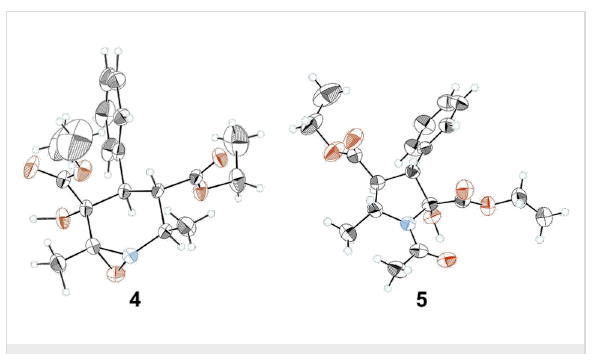
Figure 4: The X-ray structures of compounds 4 and 5 .